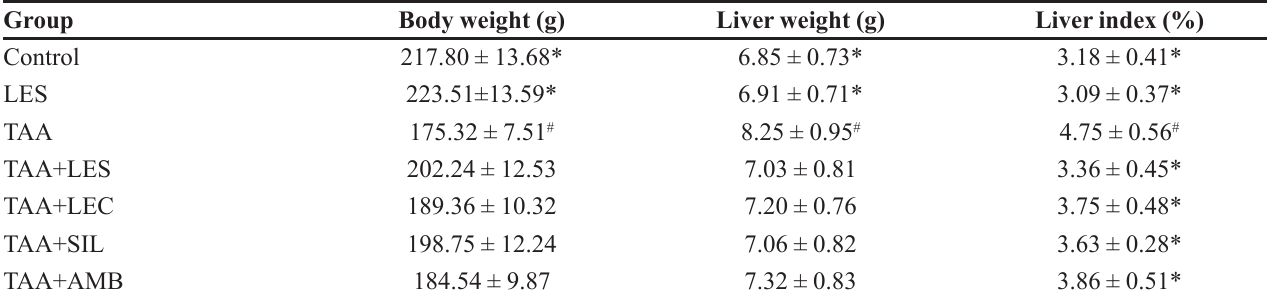
The data were stated as mean ± SD. Means with different superscripts are significantly different. * P < 0.05 versus TAA group and # P < 0.05 versus TAA+LES group. LES stands for Lesimarin. TAA stands for thioacetamide. LEC, SIL, AMB stand for lecithin, silymarin, Artemisia messerschmitiana Besser,